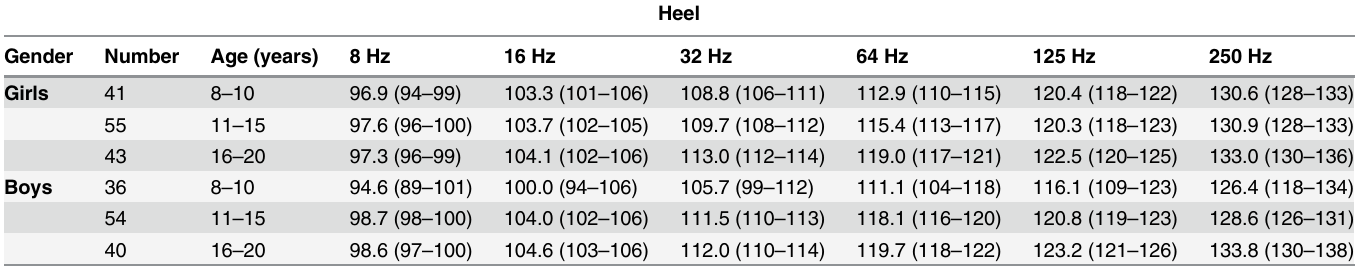
Table 2. Vibration perception thresholds at the heel in the sole of the foot at different frequencies in 269 healthy girls and boys.